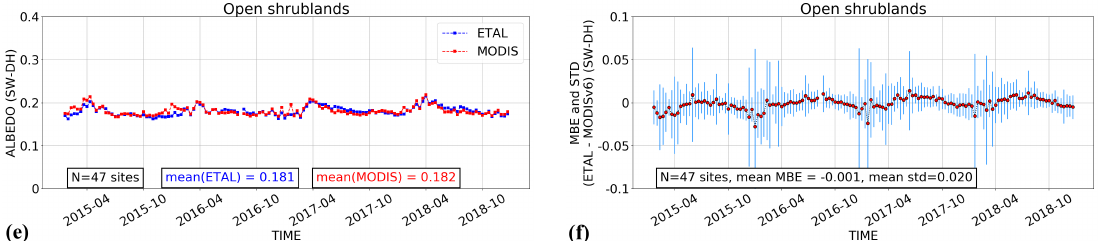
Figure 10. Time series of ETAL versus MODIS for specific land covers. We calculated the average of the surface albedo for both satellite products and the MBE and STD of the differences for ( a , b ) Evergreen needleleaf forest, ( c , d ) Croplands and ( e , f ) Open shrublands over a collection of sites (chosen from the AERONET network). The number of sites used per land cover type is denoted by N. The mean value of the mean surface albedo for both satellite products over the period 2015–2018 is given (left-hand-side figures). The mean MBE and the mean standard deviation (STD) of the differences between the two products are also given (right-hand-side figures).